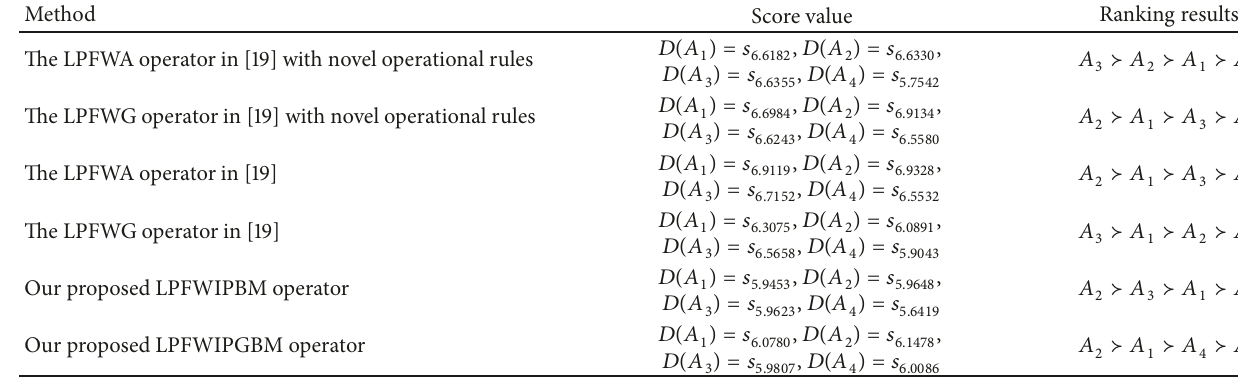
Table 10: The ranking results of our proposed operators and the operators in [19].